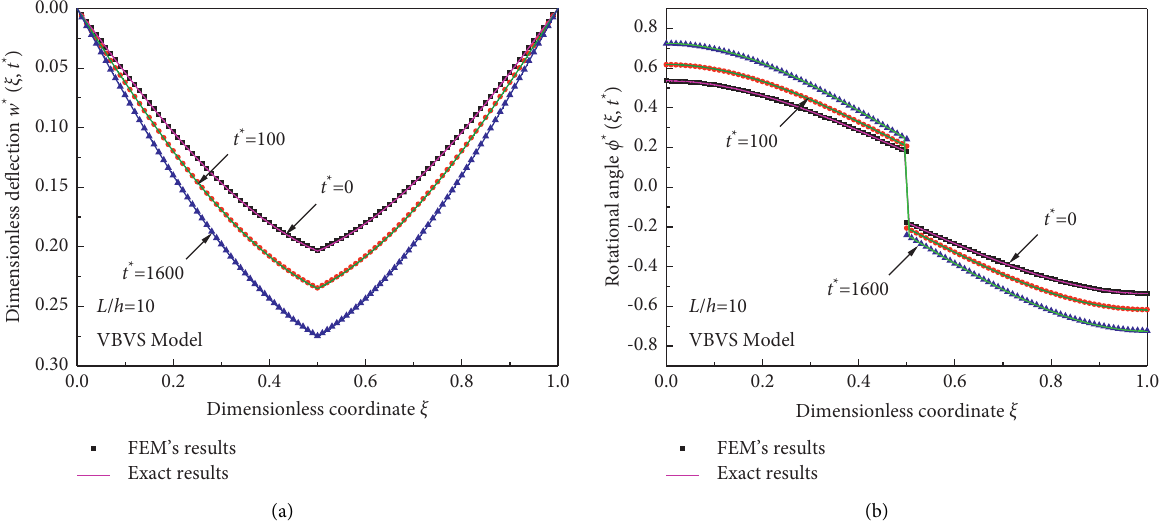
Figure 6: (a):Distribution ofdimensionless deflection w ∗ ( ξ , t ∗ )versusdimensionlesscoordinate ξ ofviscoelasticcrackedbeam withVBVSmodel. (b): Distribution of dimensionless rotation angle φ ∗ ( ξ , t ∗ ) versus dimensionless coordinate ξ of viscoelastic cracked beam with VBVS